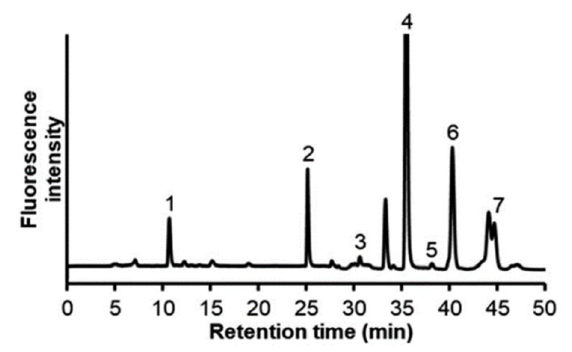
Figure 11. Chromatogram of 1,2-diamino-4,5-methylenedioxybenzene (DMB)-α-keto acids in K562 cell sample. Peaks: 1, DMB-α-ketoglutaric acid; 2, DMB-pyruvic acid; 3, DMB-α-ketobutyric acid, 4,